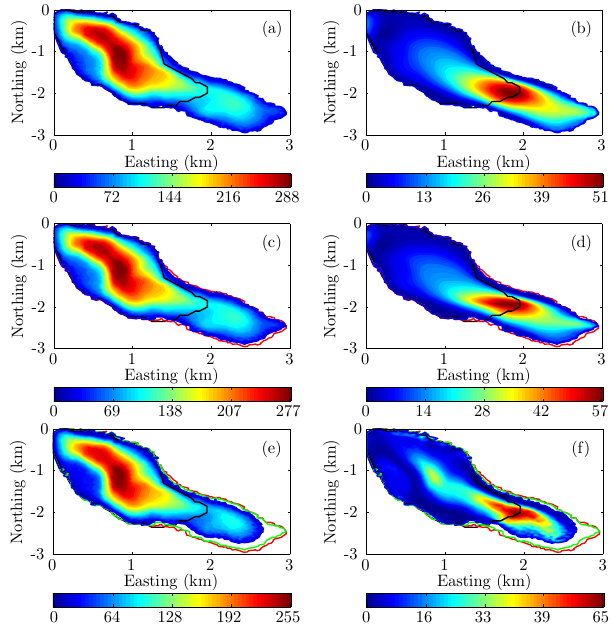
Fig. 9. Steady-state ice thickness (m; left panel) and velocity (ma − 1 ; right) distributions under the idealized glacier advance sce- nario. For 1T s = − 2 ◦ C, results are shown for (a–b) FS, (c–d) PS, and (e–f) SD models. Red (FS) and green (PS) lines are the steady- state glacier outlines. The present-day glacier extent is also shown (black line). Notice that, for better readability, we use different color scales for each model case.